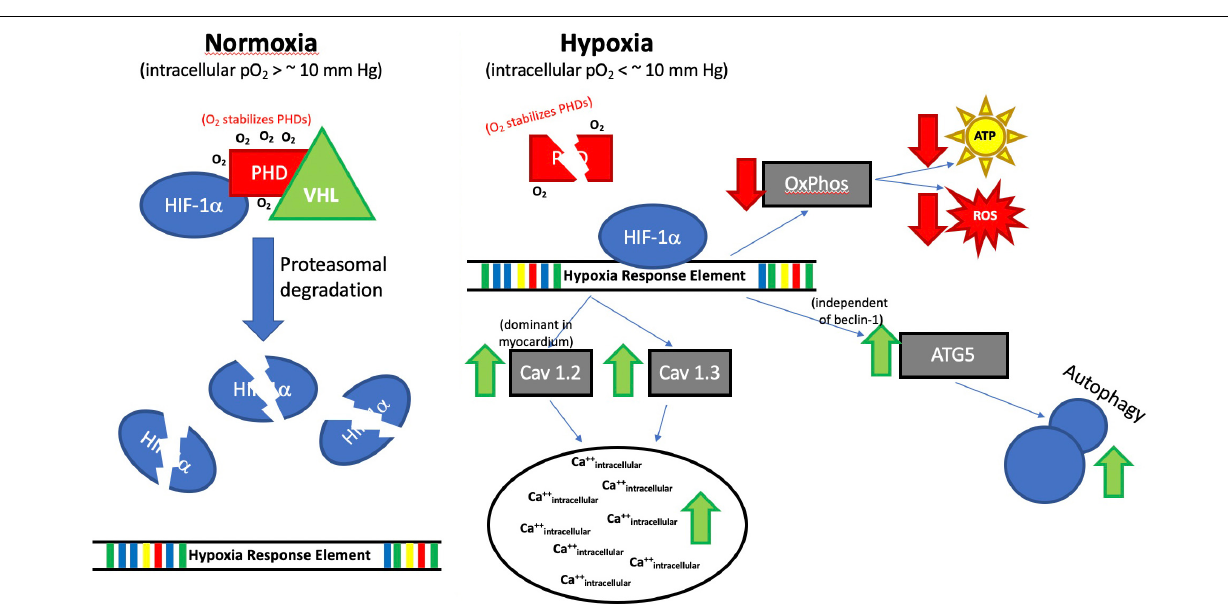
FIGURE 12 | Proposed Impact of Hypoxia on HIF-1 α . Although the full regulatory mechanism (Hypoxia → HIF-1 α → Ca ++ /autophagy) still needs to be fully studied. Our results suggest that HIF-1 α exerts several effects in H2c9 cells exposed to hypoxia, including upregulation of both Cav 1.2 and 1.3, which results in an increase in intracellular Ca ++ , increased ATG5 and autophagy through a beclin-1 independent mechanism, and reduced ATP and ROS production likely through a general slowdown in oxidative phosphorylation (OXPHOS). Prolyl hydroxylase domain protein (PHD), Von Hippel Lindau (VHL), Oxygen (O 2 ), PO2 (partial pressure of oxygen), millimeters of mercury (mm Hg), Hif1 α , Calcium channel, voltage-dependent, L type, alpha-1C subunit (Cav1.2), Calcium channel, voltage-dependent, L-type, alpha-1D subunit (Cav1.3), Adenosine triphosphate (ATP), Reactive oxygen species (ROS), ATG5 (Autophagy Related 5), Beclin-1, Autophagy Related (Becn1), ↑ increased, ↓